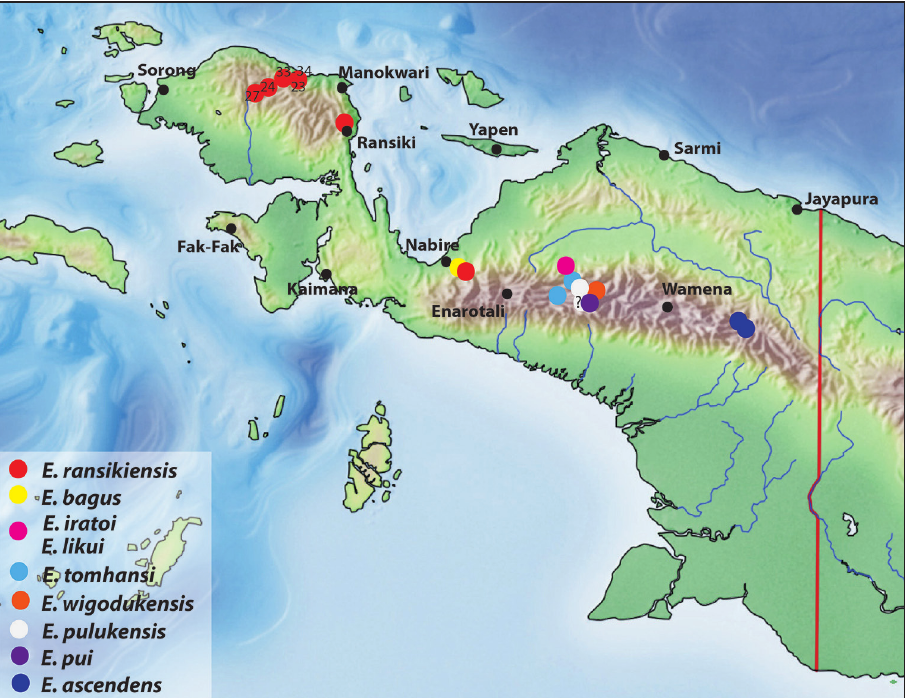
Figure 19. Map of the western part of New Guinea showing the species